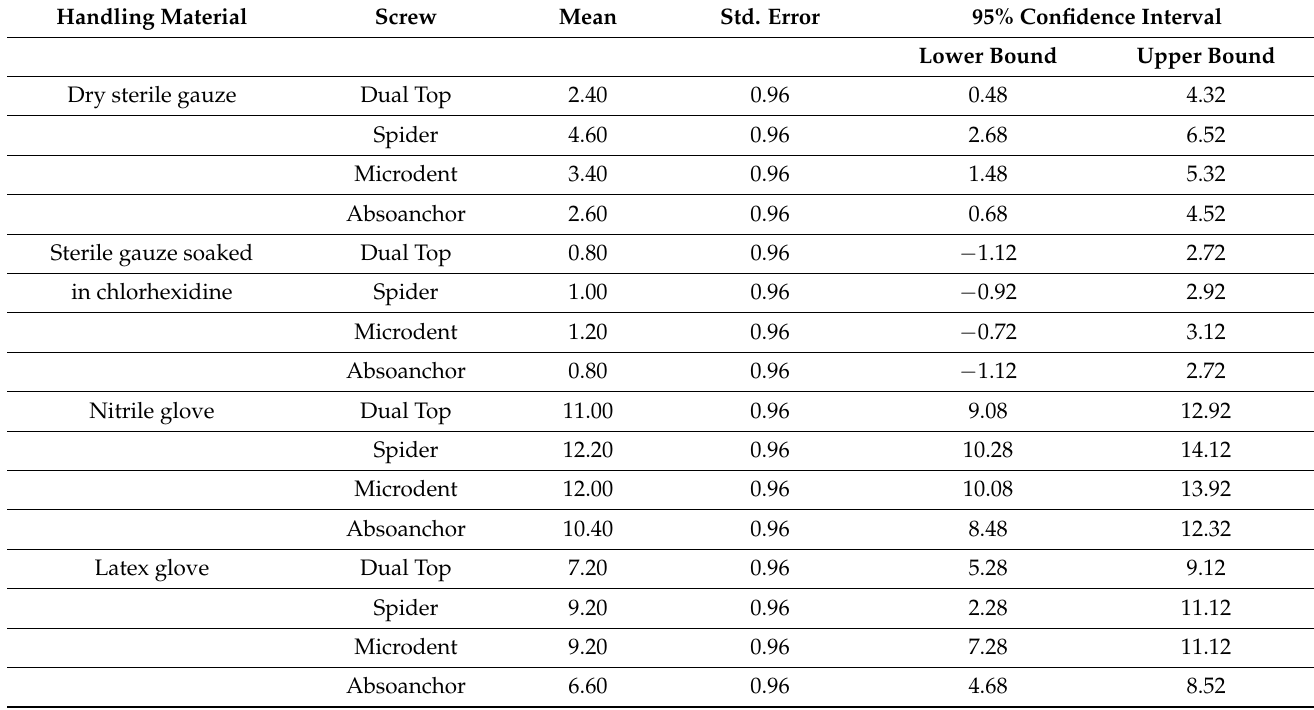
Table 2. Number of particles left by the handling materials on the ROI of each of the OMIs brands. Note the elevated number of particles left by the nitrile glove when compared with the other